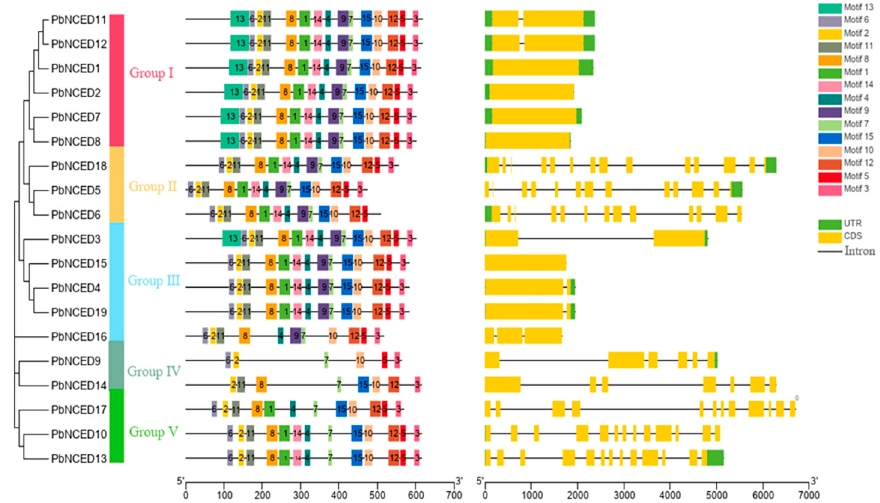
Figure 3. Phylogenetic relationship ( left ), conserved motif ( middle ), and gene structure ( right ) of PbNCED gene family protein.